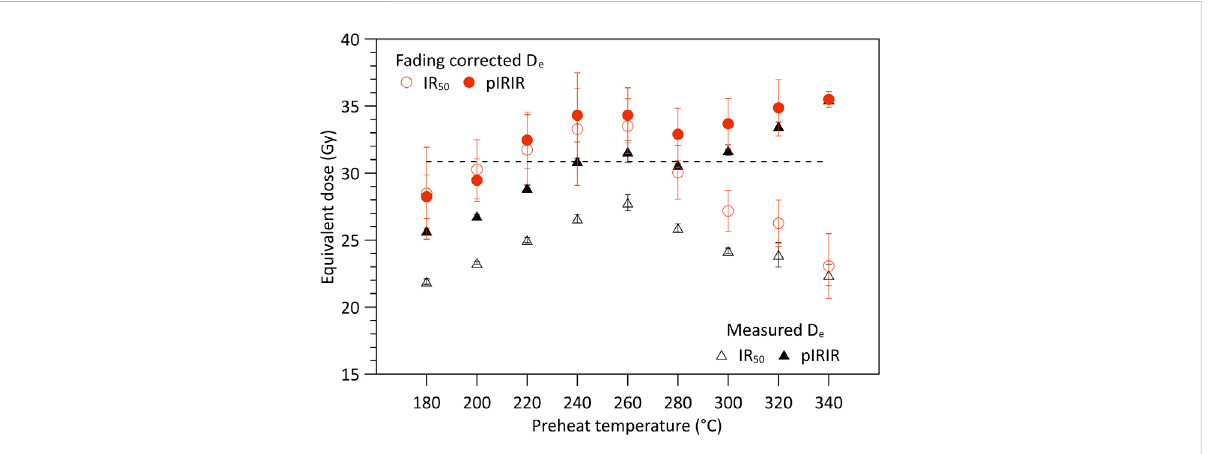
FIGURE 3 D e values measured in the laboratory (triangles) and fading corrected D e s according to Zhang et al. (2015a). The dashed line denotes the expected D